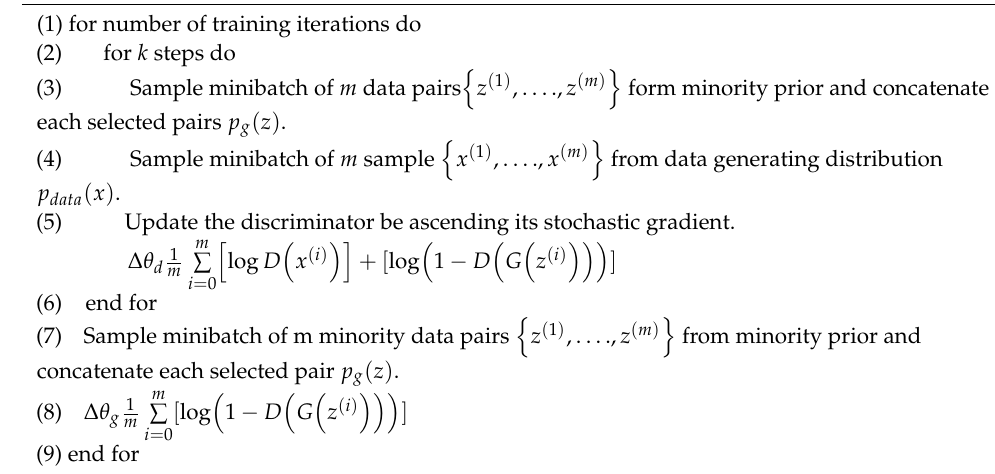
Algorithm 4: Minibatch stochastic gradient descent training of Deep Adversarial